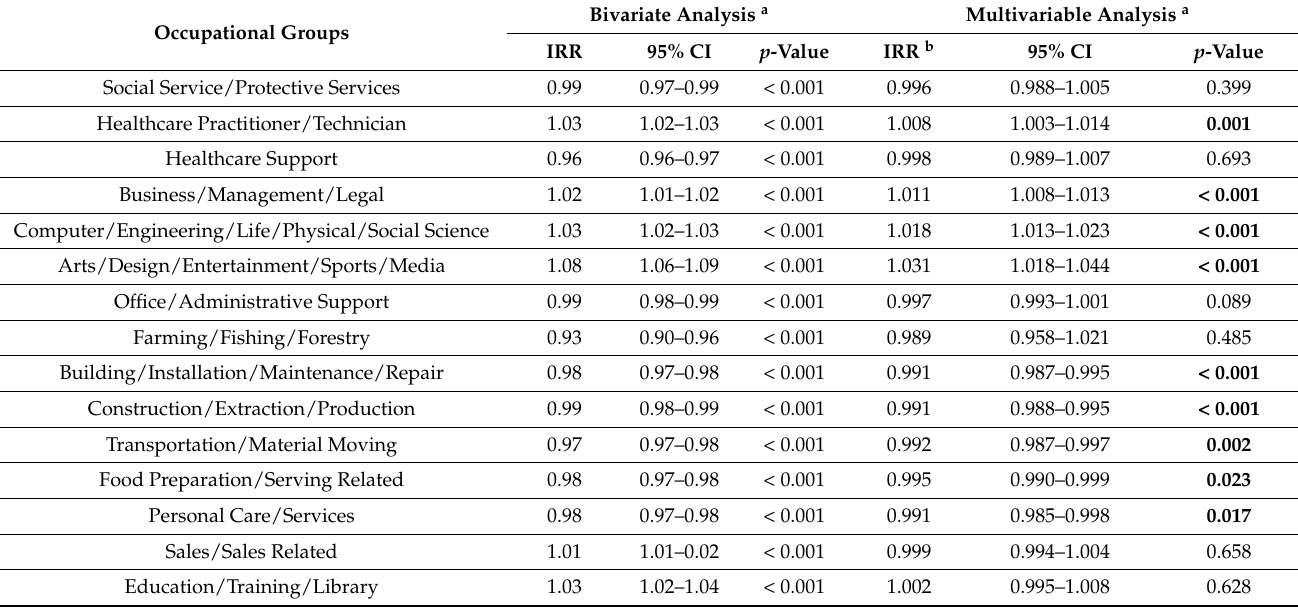
Table 2. The associations between COVID-19 vaccine uptake in Harris County and the percentage of census tract residents that were employed in each of the US standard occupational groups ( n = 774 census tracts) up to August